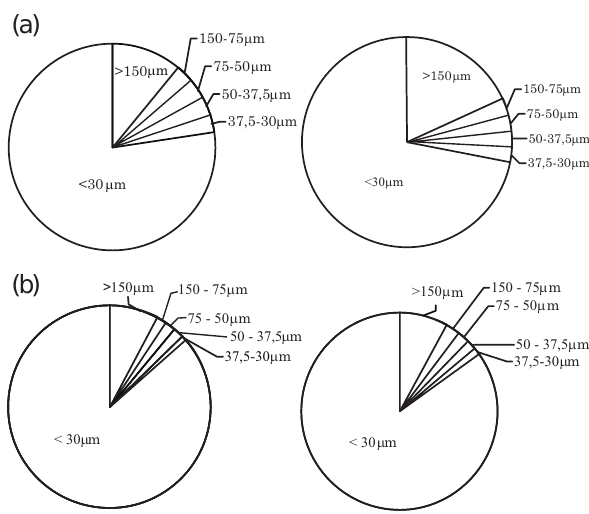
Figura 1. Distribuição de poros por tamanho de amostras de solos com estrutura indeformada coletadas na camada de 0-15 cm nos solos irrigados, com águas do rio e do poço, respectivamente, no período de estiagem (a) e no período chuvoso